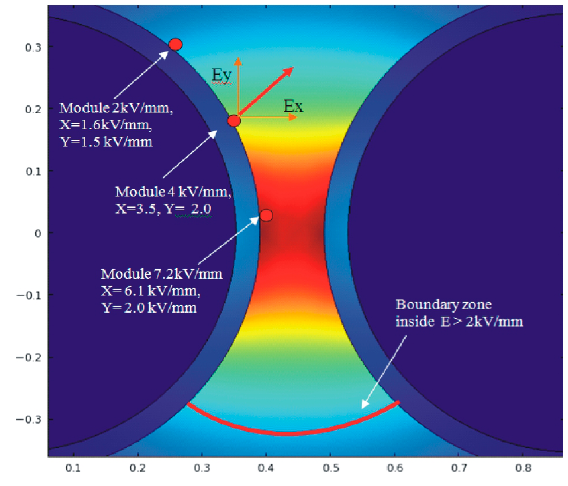
Figure 13. The 2D electric field strength distribution for two parallel wires with 100 μ m air ‐ gap.